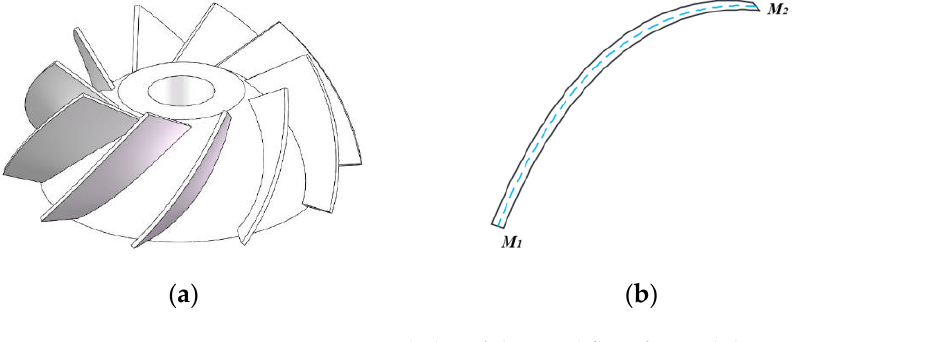
Figure 7. Blades of diagonal flow fan and their parameterization. ( a ) Diagonal flow fan impeller. ( b ) Arc line in blade. ( c ) Blade parametric coordinates.